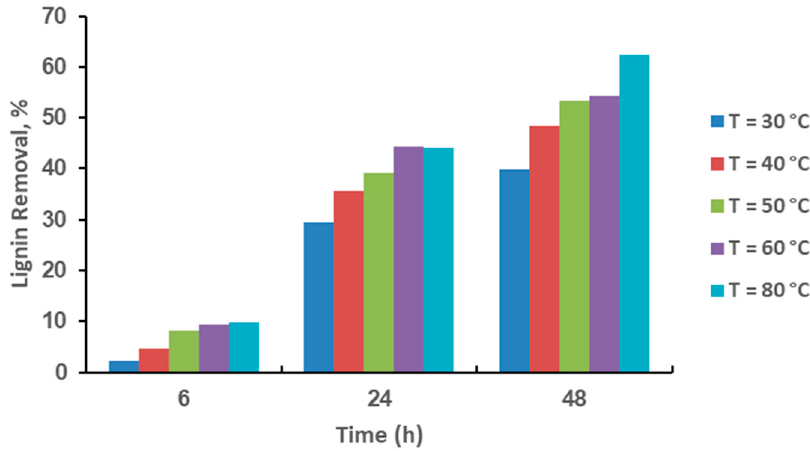
Figure 1. Effects of HP pretreatment time and temperature on lignin reduction.